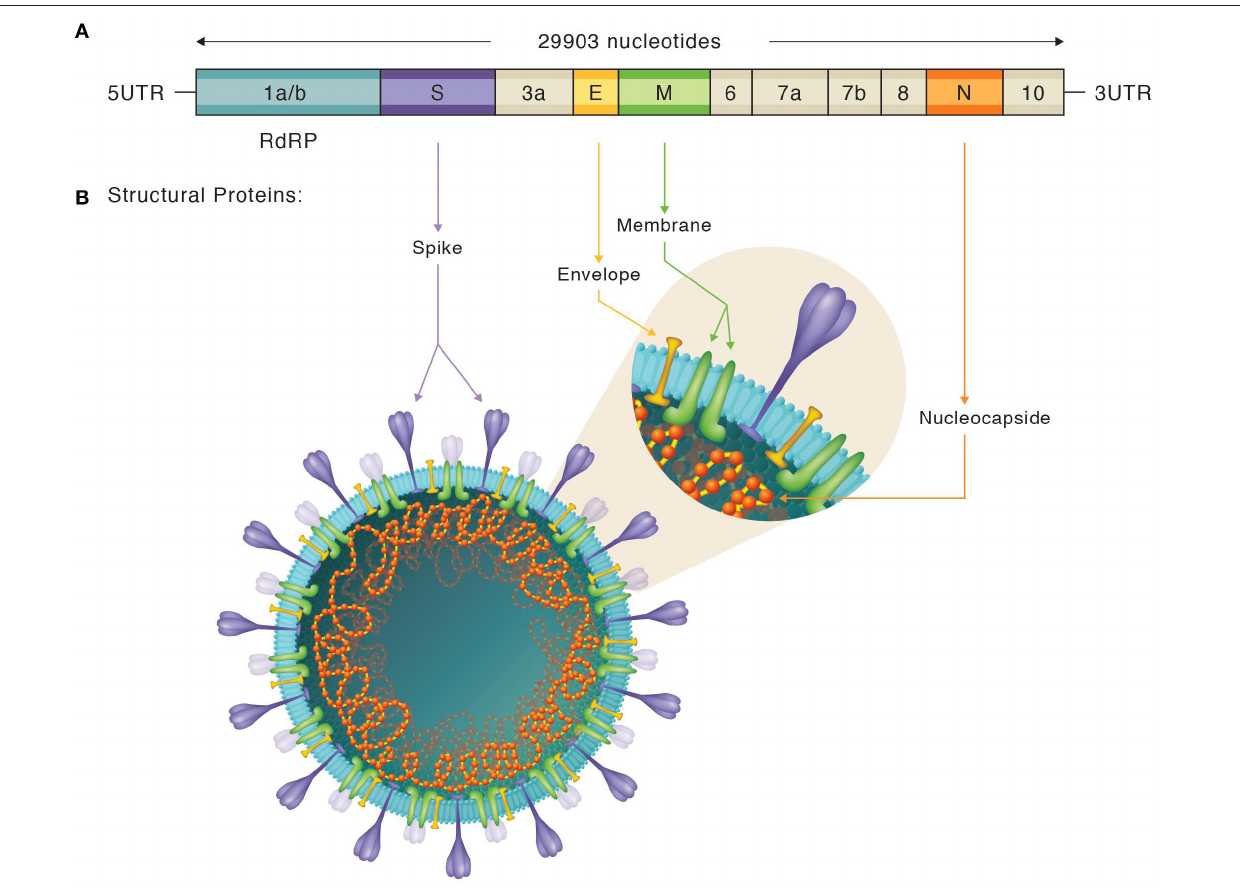
FIGURE 1 | Depiction of SARS-CoV-2 genome and structure. (A) Organization of the SARS-CoV-2 genome. Both structural and non-structural proteins are represented. Figure adapted from both the Khailany et al. and Chan et al. studies ( 22, 42). (B) Illustration of SARS-CoV-2 structure, locating, and labeling all the structural proteins. Spike proteins subdomains are also